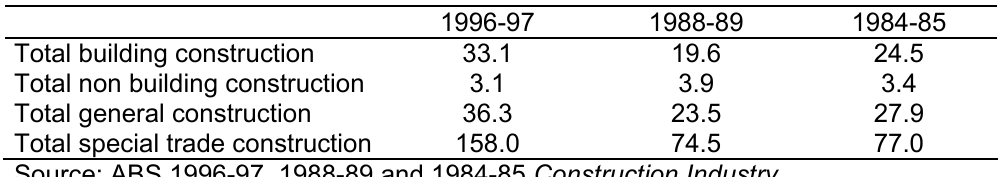
Table 2. Private Sector Construction Establishments: Number operating during the